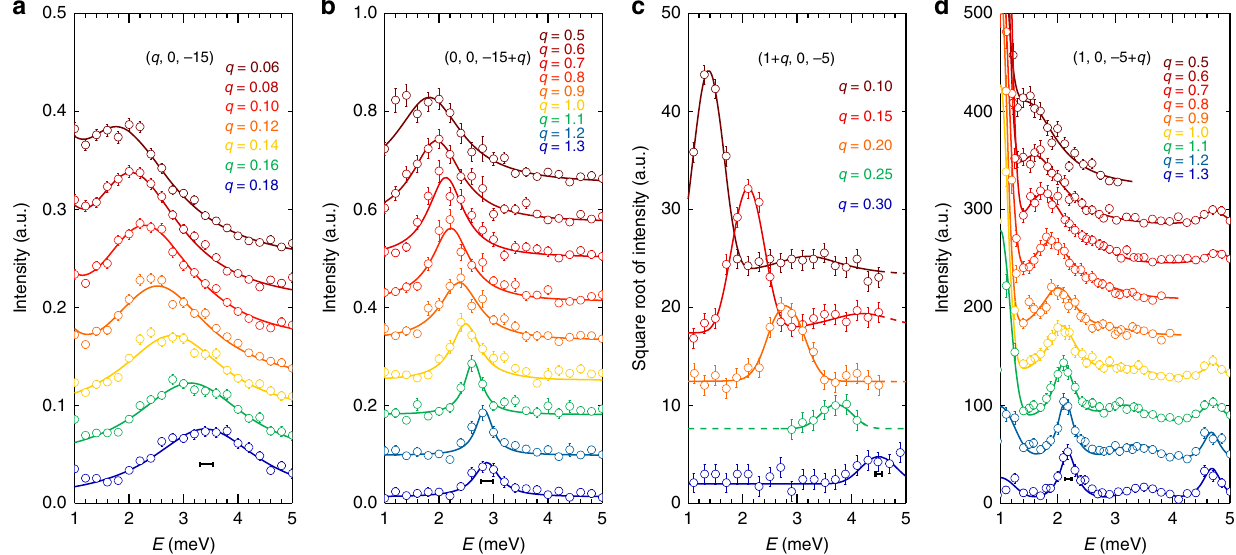
Fig. 3 Energy cuts on the phonon dispersions. a – d Correspond to the energy cuts on the dispersions plotted in Fig. 2a – d at different q values. The cuts are offset so that each cut can be visualized clearly. In c due to the large intensity difference of phonons at small and large q s, we plot the square root of the intensities as a function of energy so that the cut pro fi les at large q s can be visible. Solid lines are fi ts with Lorentzian functions convoluted the instrumental resolutions, as indicated by the horizontal bars. From the fi ts, we obtain the phonon dispersions, which are plotted as solid lines in Fig. 2. Errors represent one standard deviation throughout the